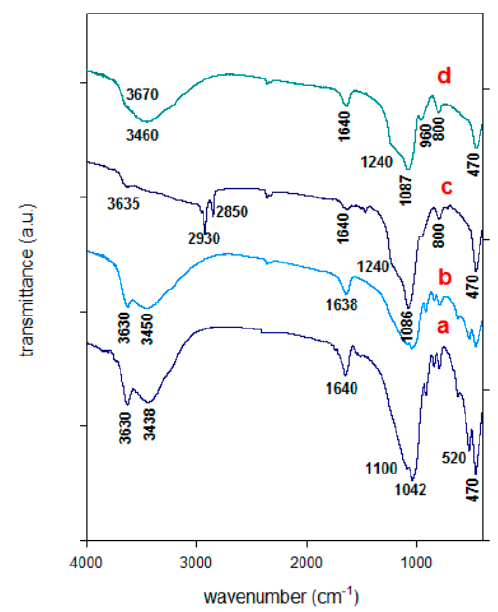
Figure 4. FTIR spectra of ( a ) starting Ca-Mt, ( b ) Al-Mt, ( c ) Al-PCH precursor; and ( d ) corresponds to ( c ) after calcination at 550 °C.